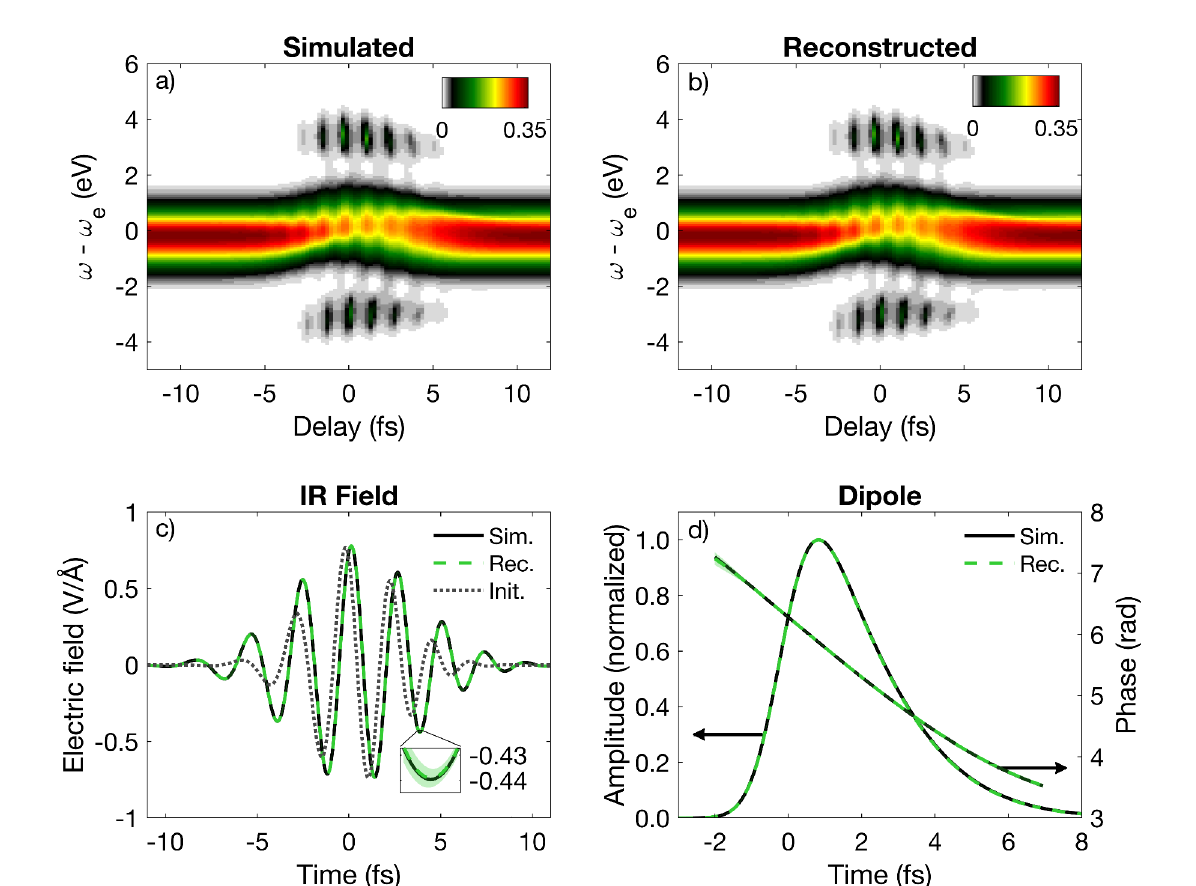
Figure 2. Simulated, a), and reconstructed, b), transient reflectivity trace associated to an excitonic transition, described by the pa- rameters of Table1. c) Simulated, black solid, and reconstructed, red dashed, dipole moments. d) IR field: simulated, black solid, reconstructed, red dashed, and an example of initial guess, gray dotted. Both amplitude and phase of the dipole moment O ( t ) are correctly reconstructed. Notice, also, that the ptychographic approach also allows for the retrieval of the IR